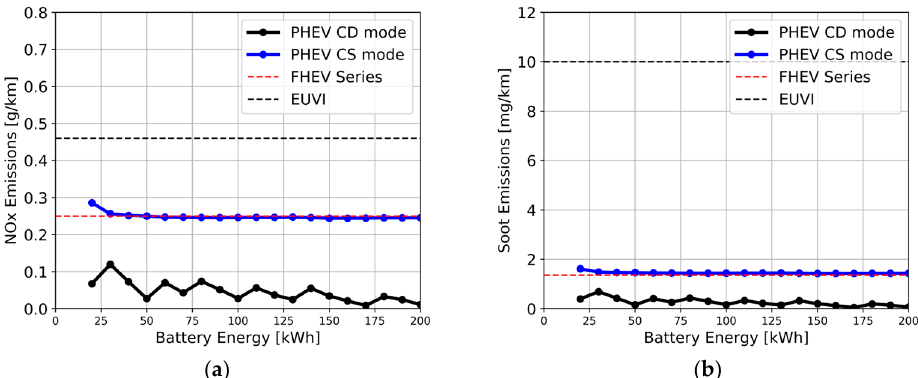
Figure 16. Engine NOx ( a ) and engine soot ( b ) emissions under a WHVC with 50% payload. EUVI limit and full hybrid are added for comparison.